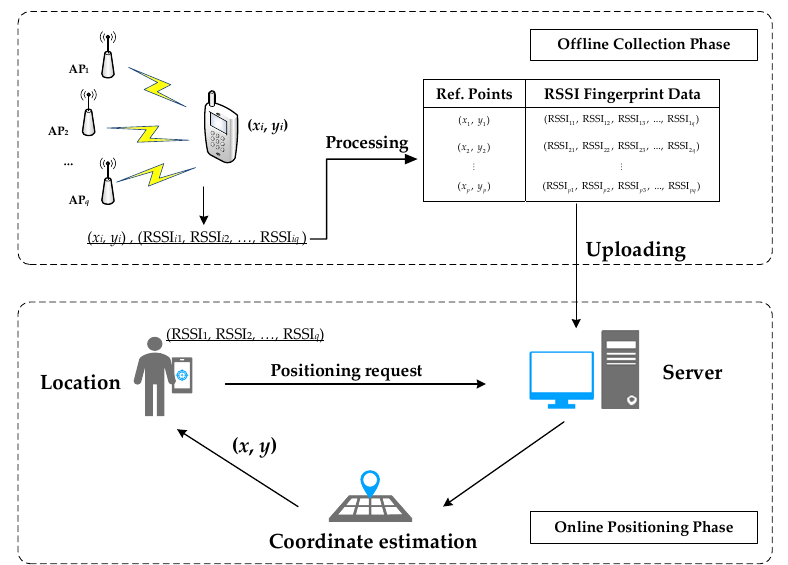
Figure 2. Schematic diagram of RSSI-based fingerprint positioning. Suppose that there are q APs deployed in the network and the number of RPs is p . The set of RPs and APs can be expressed as W RP and W AP , W RP = {RP 1 , . . . , RP i , . . . , RP p } and W AP = {AP 1 , . . . , AP j , . . . , AP q }. The RSSI vector collected at the i th RP is S i , S i = {RSSI i 1 , . . . , RSSI ij , . . . , RSSI iq }, and the coordinate of the i th RP is l i = ( x i , y i ).